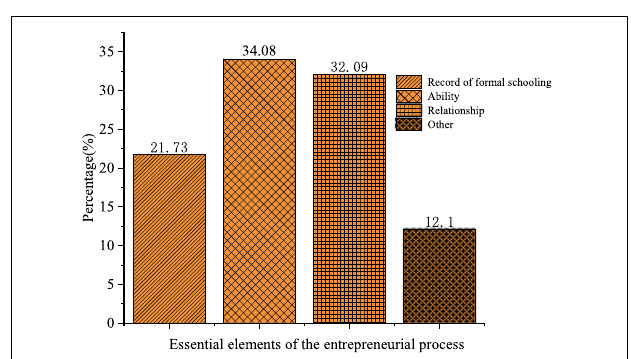
FIGURE 2 | Essential elements for the entrepreneurial process.